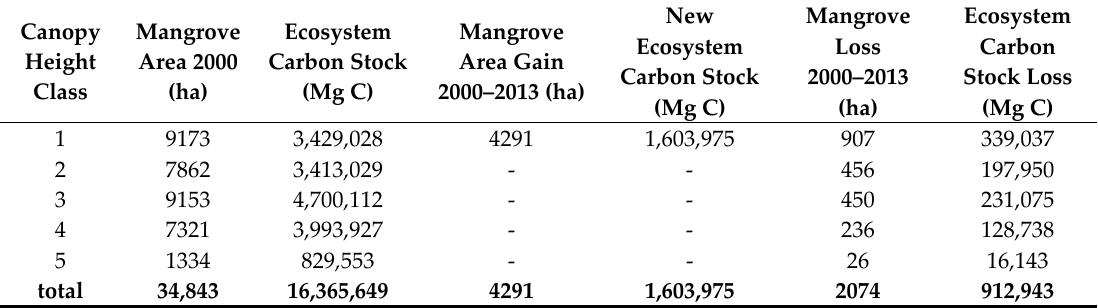
Figure 6. Mangrove extent in 2014, mapped by canopy height class. Higher height classes have greater total biomass; refer to Table 2 for above and below ground biomass estimates from the carbon inventory. Table 6. Ecosystem stock of mangroves in 2000, and gains and losses attributed to changes in mangrove extent through 2013. Carbon density assumed to be constant over the assessment period. Canopy height class used as the basis for carbon inventory